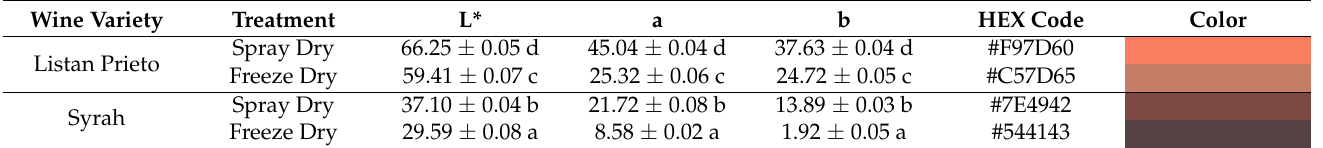
Table 2. CIE Lab color parameters and HEX color code of dried wine samples.